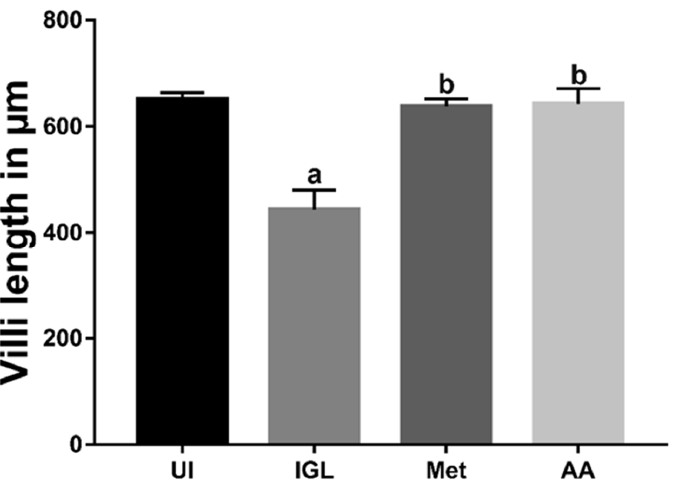
Figure 4. Treatment with A. annua preserved villi length in infected hamsters. A. annua extract treatment protected villi in infected hamsters. This effect was comparable to metronidazole treatment. “ a ” indicates significant difference versus UI group and “ b ” indicates significant difference versus IGL group ( p < 0.001). Data are presented as means ± SD (n = 3) and were analyzed using ANOVA test to compare the mean differences between groups with Bonferroni corrections as a post hoc